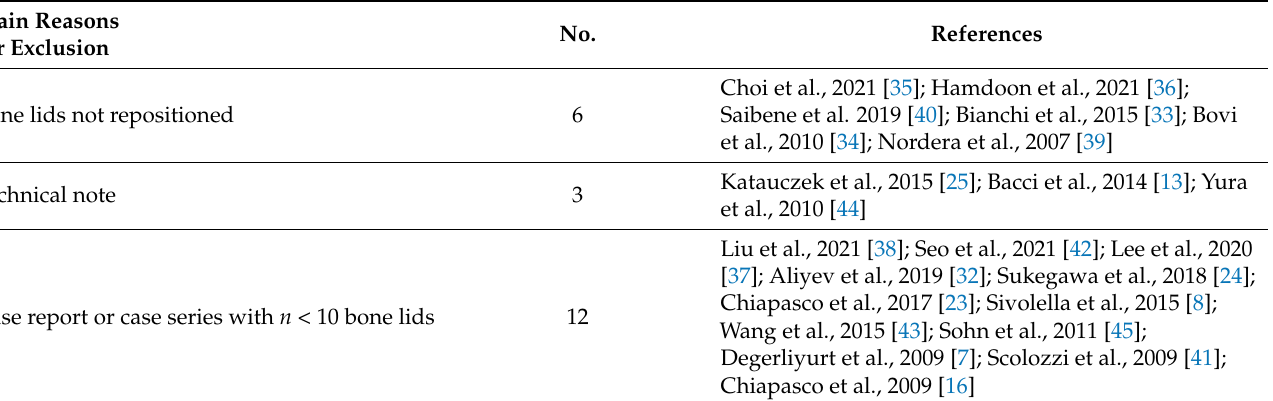
Table 2. Main reasons for exclusion after full-text